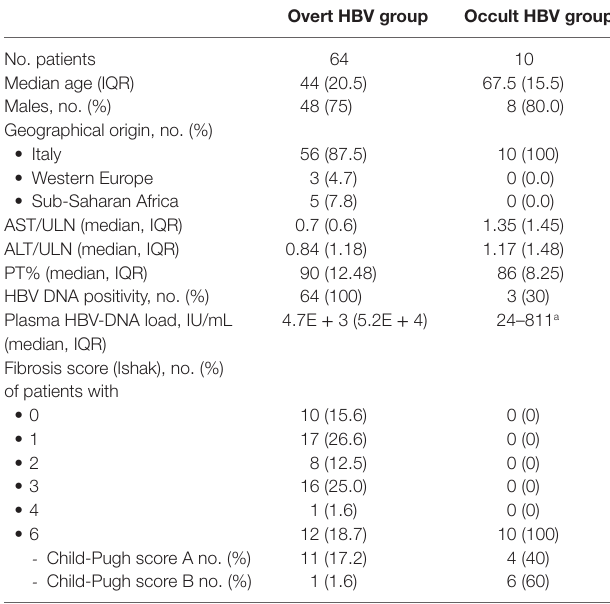
TaBle 1 | Demographic, biochemical, virological, and histological characteristics of the enrolled patients according to the etiologic group. Overt hBV